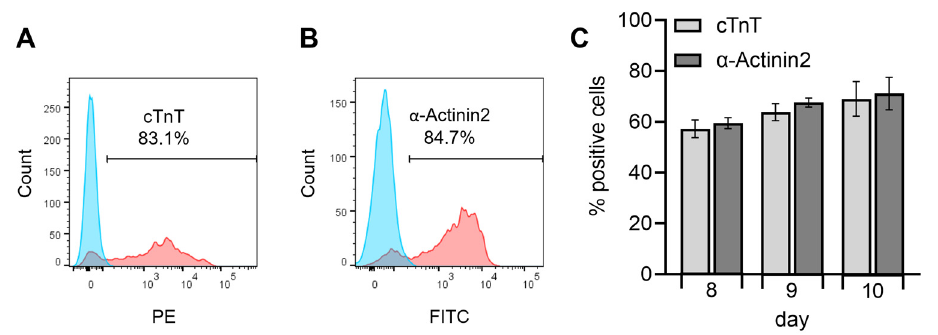
Figure 7. Flow cytometry analysis of human induced pluripotent stem cell (hiPSC)-derived cardiomyocytes analyzing the cardiac-specific proteins cardiac muscle Troponin T (cTnT)-PE and α -Actinin2-FITC, including fixable viability stain 510 (FVS510) as a live/dead discriminator on days 8, 9, and 10 of the differentiation protocol (Figure 3A). Human iPSCs were differentiated into cardiomyocytes in replicates of 16 for every day of analysis and pooled on the respective days. Flow cytometry analyses were performed using a BD FACSCanto™ II system operated with the BD FACSDiva™ software. Further analyses were conducted with FlowJo. ( A , B ): Exemplary flow cytometry results of day 10 for the markers cTnT-PE and α -Actinin2-FITC, blue peak: unstained cells, red peak: positively stained cells. The gate to determine a positive signal was defined through the unstained control by setting it to a maximum of 0.49% positively stained cells in the unstained control. ( C ): Results of positively stained cells for the markers cTnT-PE and α -Actinin2-FITC on days 8, 9, and 10. N = 4, ±SEM. p < 0.05 was considered significant, no statistical significance was detected.